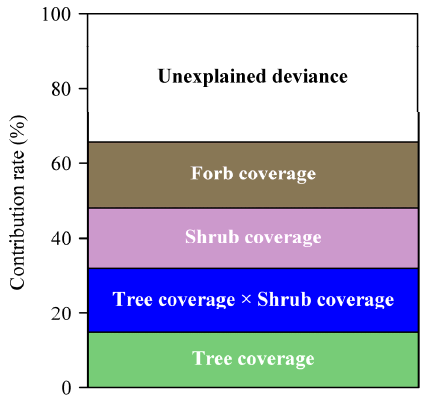
Figure 4. The panel shows the contribution rates of four explanatory variables (coverage of trees, shrubs, and forbs, plus the interaction between the coverage of trees and that of shrubs) to